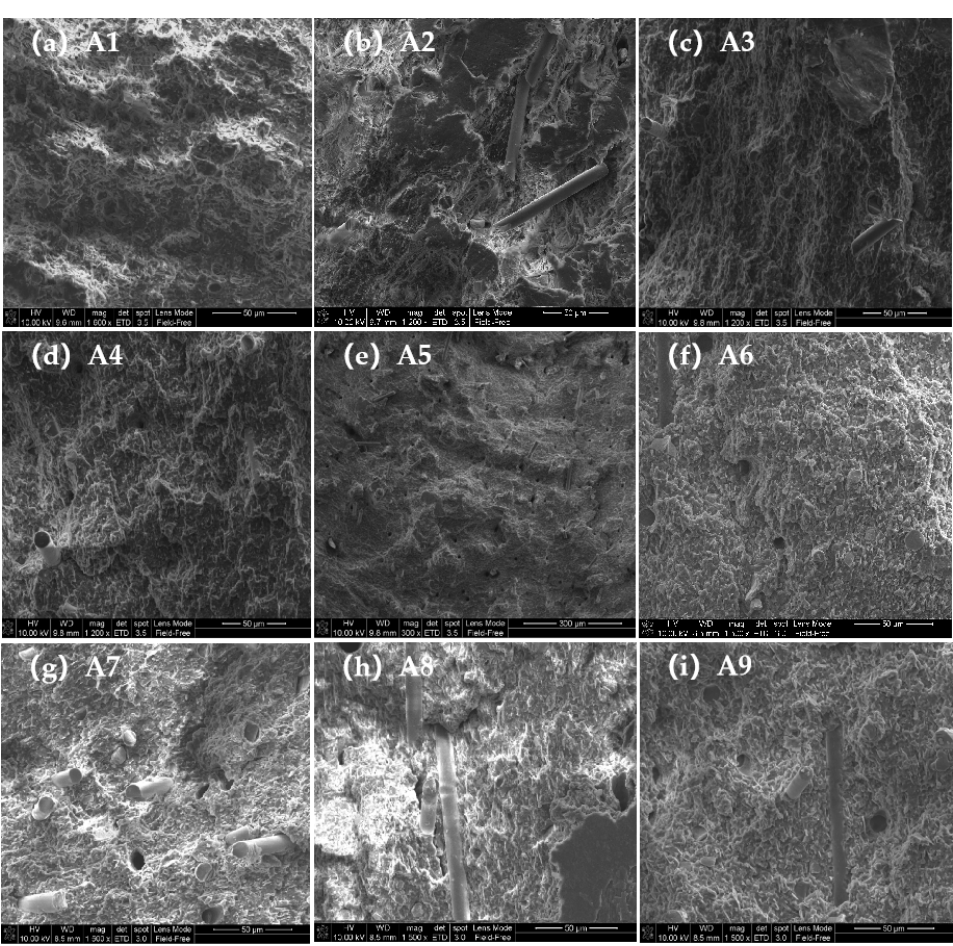
Figure 3. Izod impact strength of different PLA/PBS composites.